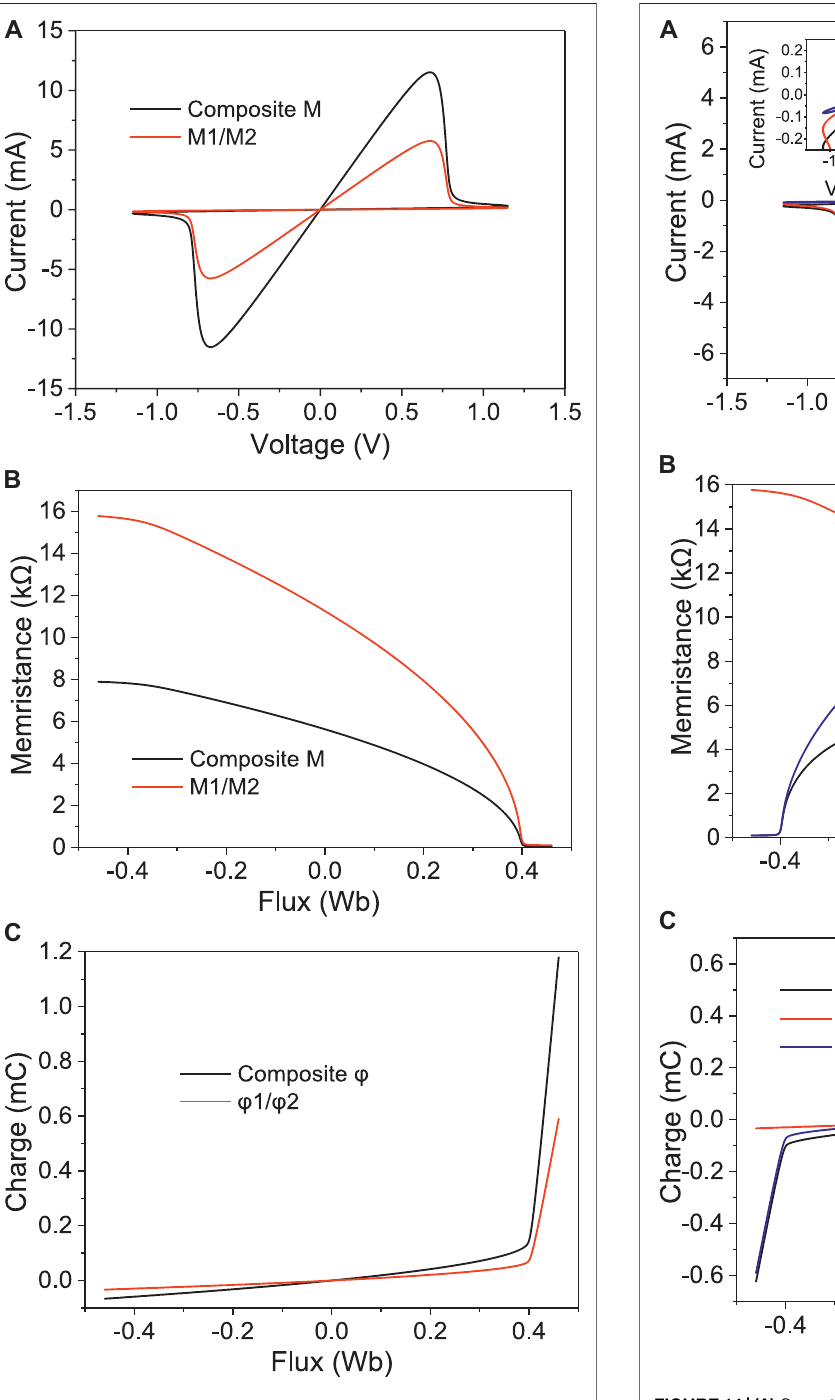
FIGURE13|(A) Current versusvoltage curves, (B) memristance versus fl ux curves, and (C) charge versus fl ux curves of the single memristor and two memristors in parallel with same polarities.